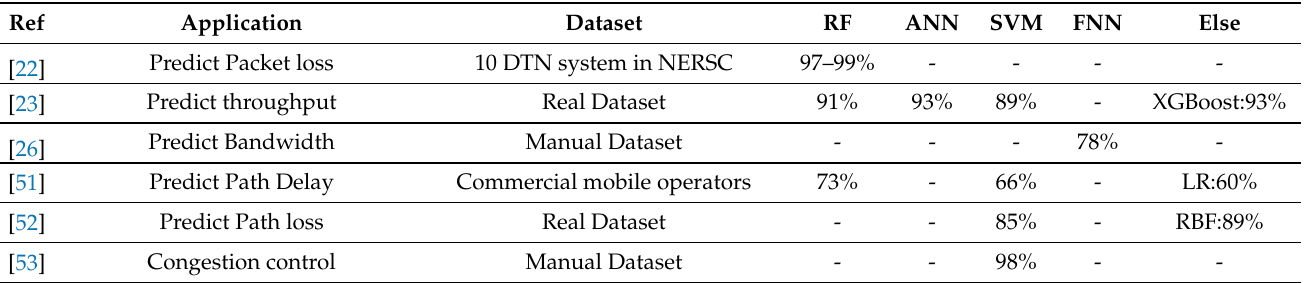
Table 2. Network Measurement Application and ML Algorithm AnalysisPrediction accuracy of different supervised ML